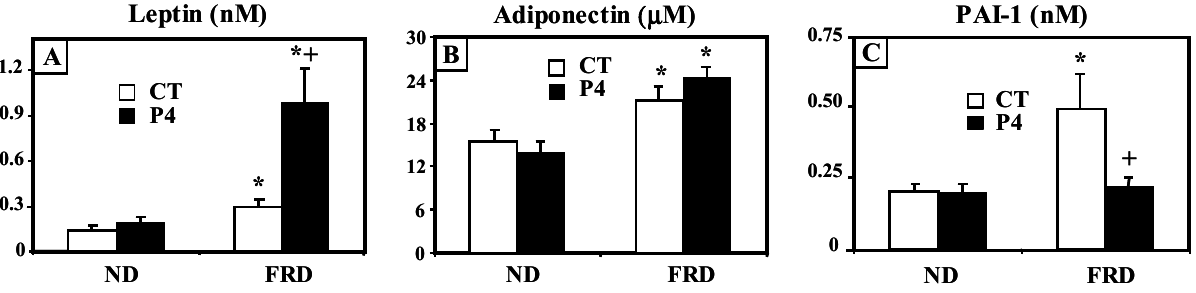
Figure 2. Leptin ( A ), adiponectin ( B ) and PAI-1 ( C ) plasma concentrations in CT and P4 rats fed a ND or FRD. Values are means ± SEM, n = 6–7 animals per